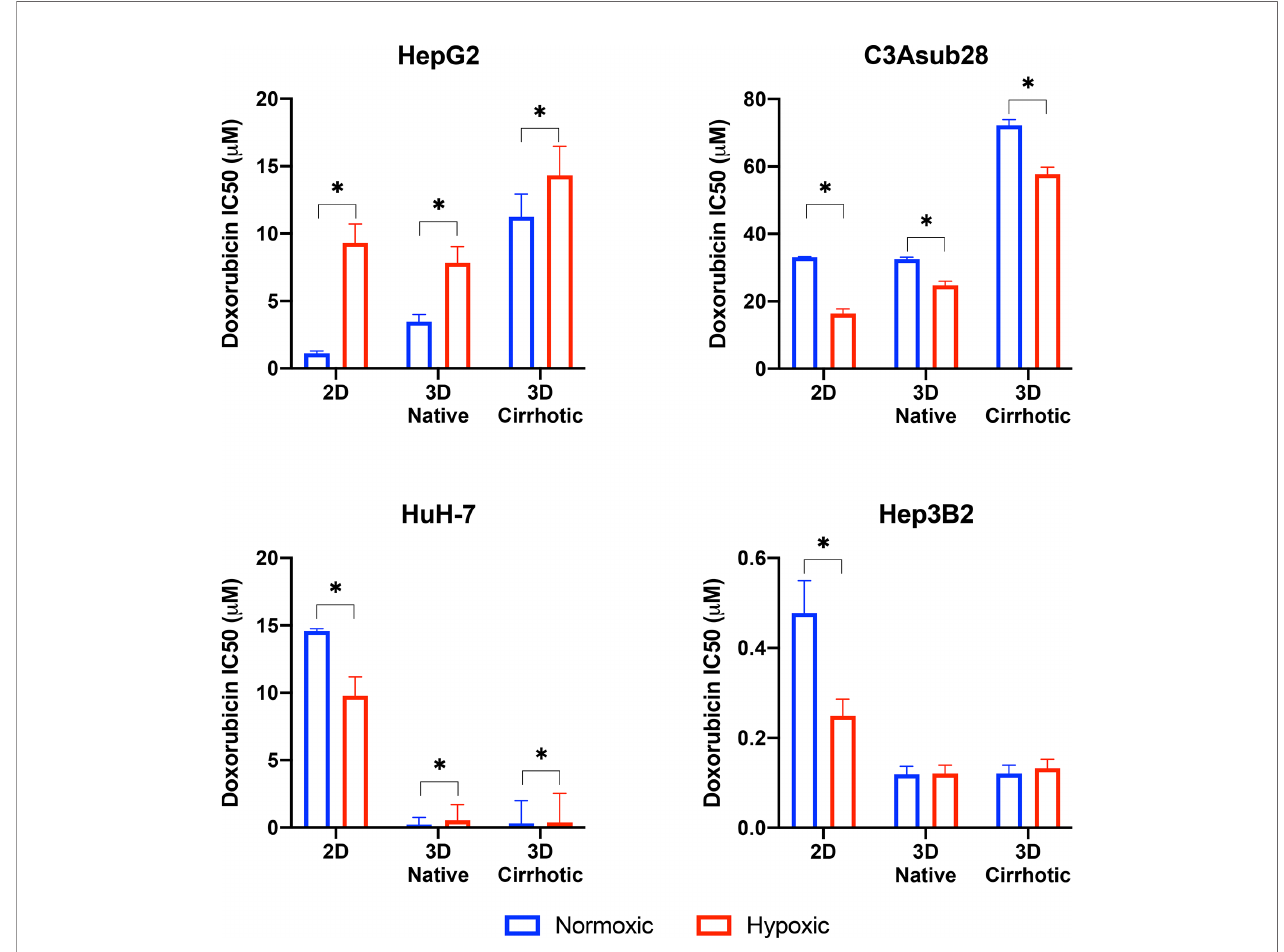
FIGURE 3 | Half-maximal inhibitory concentrations (IC 50 ) values of doxorubicin against HCC cells in different microenvironments. HCC cells have stiffness and oxygen-dependent resistance/sensitivity to 24-hour doxorubicin treatment. Cirrhosis and hypoxia altered IC 50 fi ndings differently among the HCC cell lines. 3D- normal: 4 mg/ml collagen gel, 3D-Cirrhosis: 7 mg/ml collagen gel. Statistical signi fi cance was compared to normoxic conditions. *p <